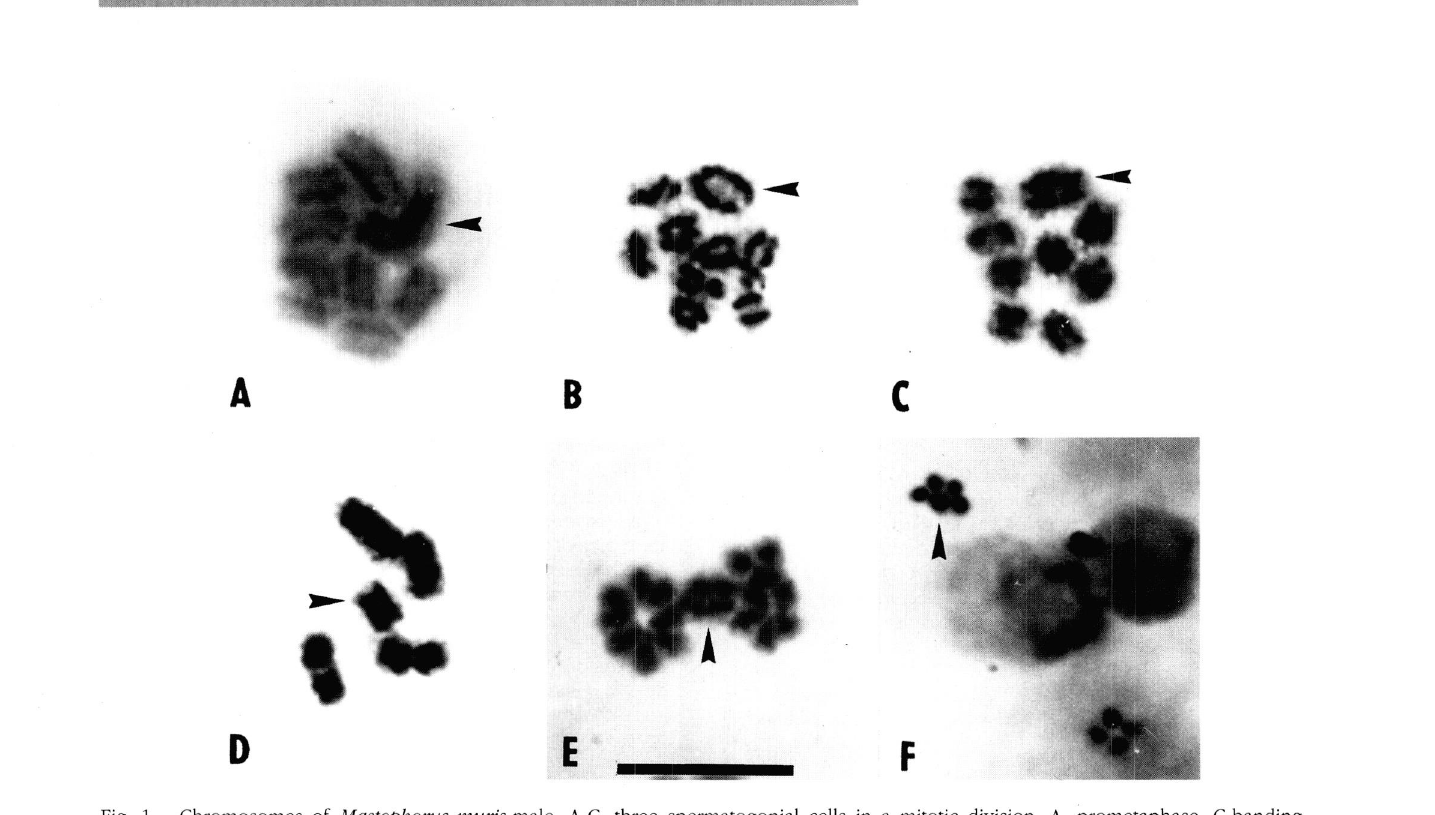
Fig. 1 - Chromosomes of Mastophorus muris male. A-C, three spermatogonial cells in a mitotic division. A, prometaphase, C-banding. B, C, metaphase. D, primary spermatocyte in the first meiotic metaphase. Complement comprising four bivalents and one univalent sex chromosome X. E, primary spermatocyte in the first meiotic anaphase. Univalent sex X chromosome located between two hapliod sets of autosome chromosomes. F, two secondary spermatocytes comprising haploid sets of four (n = 4, down) and five (n = 4 + X, upward)